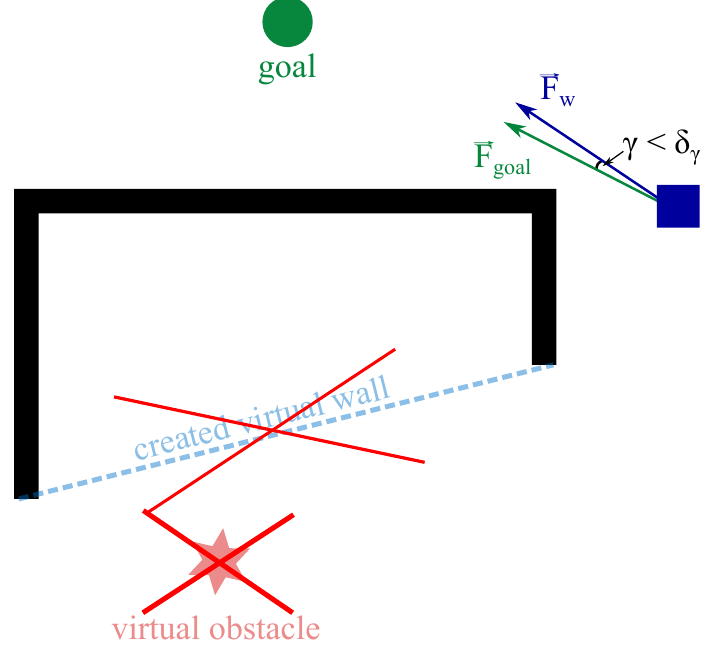
Figure 6. Abandonment of the augmented